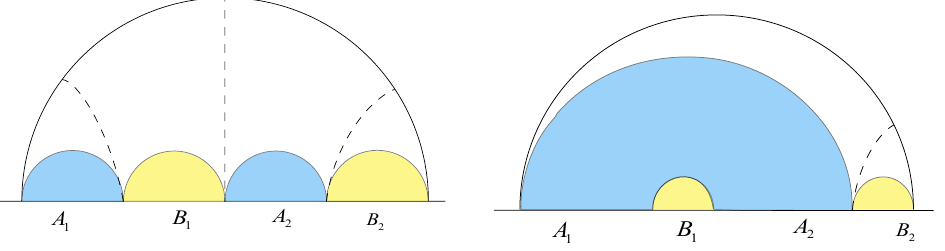
Figure 19 . Left: both entanglement wedges of A and B are disconnected. Right: the entanglement wedge of A is connected while B is disconnected. The black dashed line denotes the